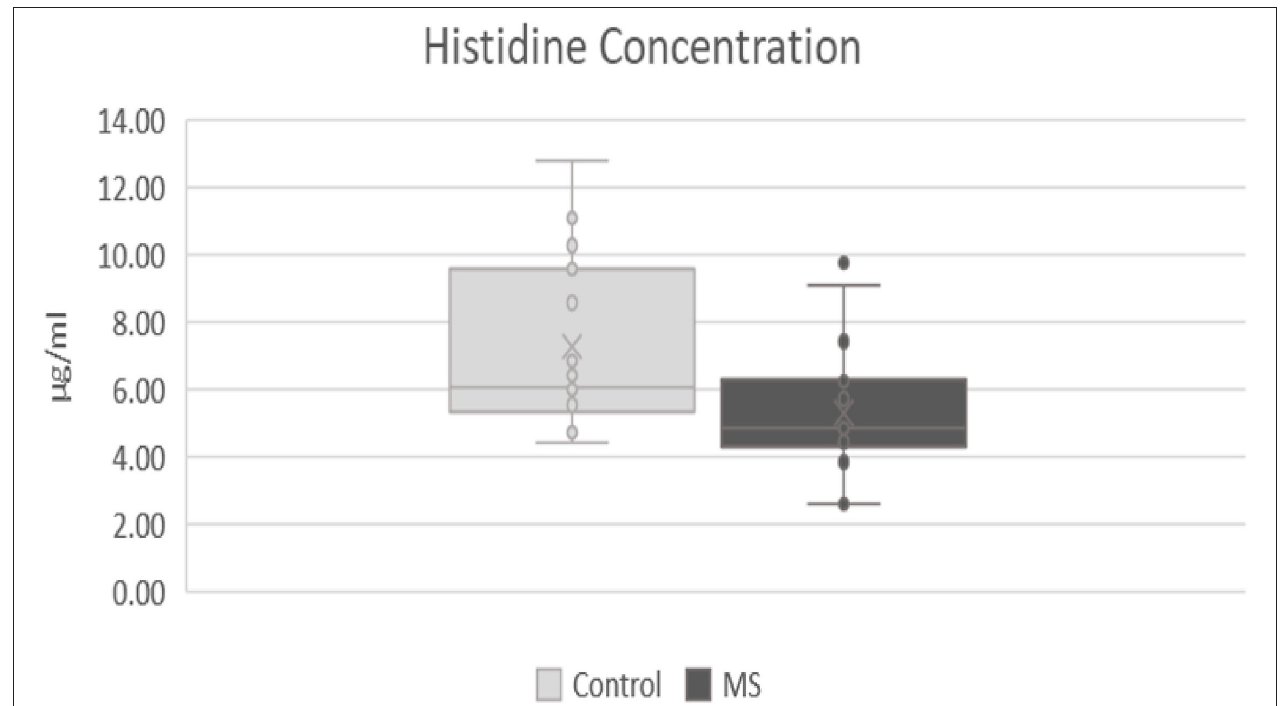
FIGURE 2 | Comparison of levels of histidine in patients after first attack of clinical symptoms fulfilling revised McDonald criteria and control group. MS, patients after first attack of clinical symptoms fulfilling revised McDonald criteria; control, control group.